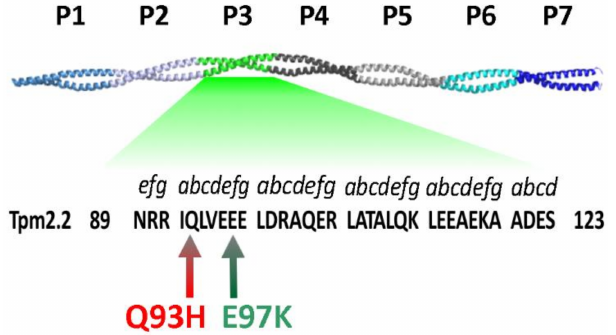
Figure 1. Localization of substitutions Q93H and E97E in the sequence of actin-binding period 3 of Tpm2.2. The coiled coil structure of tropomyosin is illustrated by the 7 Å crystal structure of Tpm1.1 (PDB: 1C1G). Actin-binding periods P1–P7 are marked with different shades of blue and grey, except for P3, which is marked with green. The arrows point to the positions of the substitutions in the sequence (amino acids 89–123) of human Tpm2.2 (NCBI: NP_003280.2). Positions of the amino acids in the heptapeptide repeat ( a–g ) are shown above the amino acid